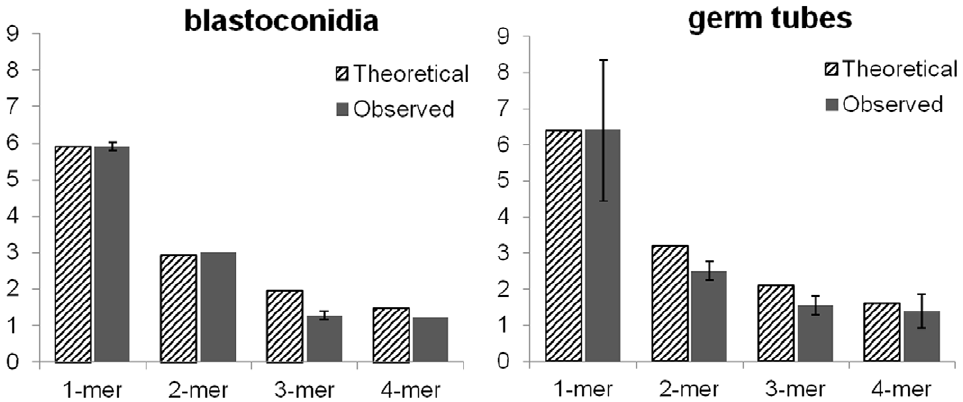
Figure 5. Theoretical and observed LC 50 values of histatin 3 mers towards C.albicans blastoconidia and germ tubes. From three independent histatin dose-effect curves, the average LC 50 values and standard deviations (SD) were determined (solid bars). The theoretical LC 50 values were calculated by dividing the observed LC 50 value for reHst3 1-mer by 2, 3, and 4, respectively (hatched bars).